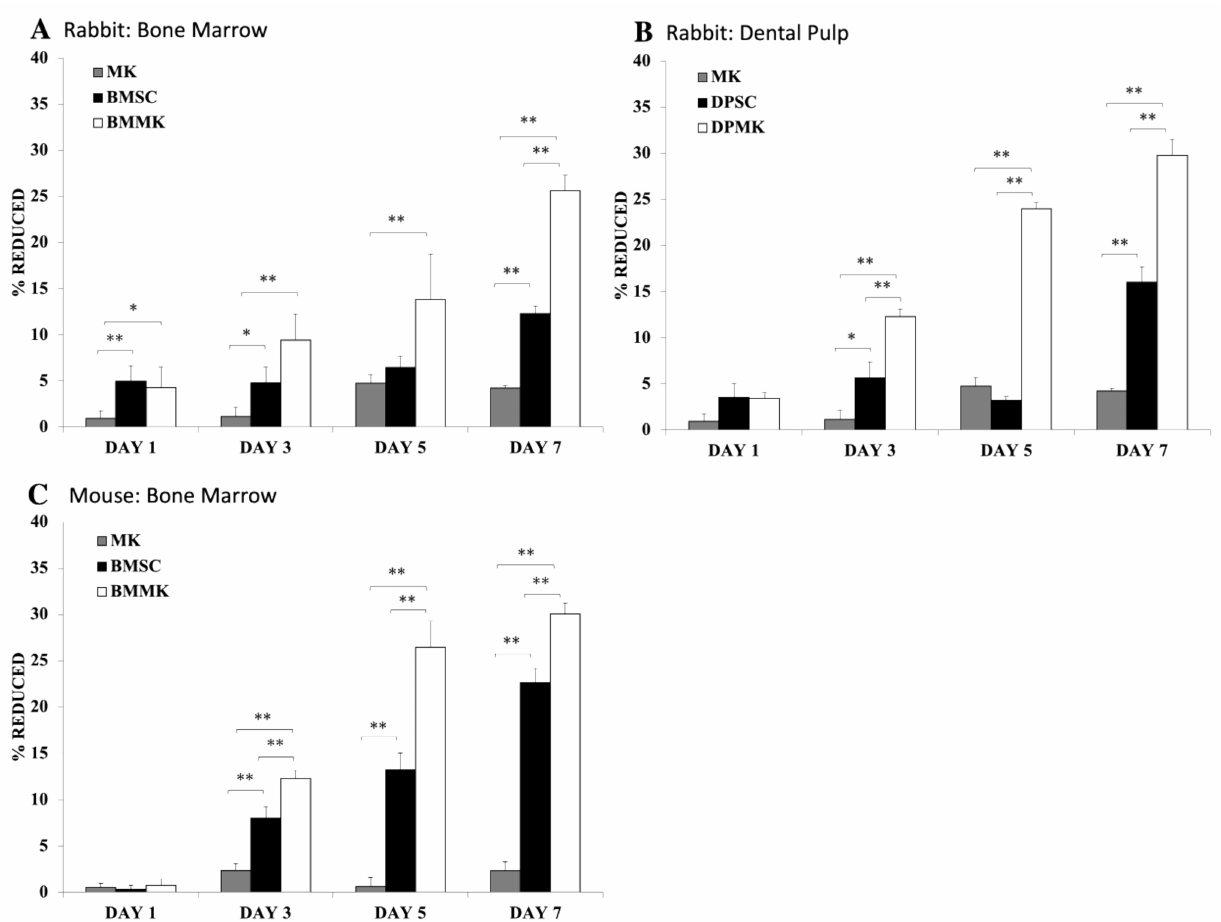
Figure 5. Shows MSC viability co-cultured with or without MKs. ( A ) shows rabbit MKs, rabbit BMSCs (BMSCs), and co-culture of rabbit MKs with rabbit BMSCs (BMMK). ( B ) shows rabbit MKs, rabbit DPSCs (DPSCs), and co-culture of rabbit MKs with rabbit DPSCs (DPMK). ( C ) shows mouse MKs, mouse BMSCs (BMSCs), and co-culture of mouse MKs with mouse BMSCs (BMMK). MSC viability was assessed on days 1, 3, 5, and 7. Increased levels of MSC viability are observed when MSCs are co-cultured with MKs at different time-points. Error bars reflect the standard deviation of the mean. A significant difference between the groups is indicated by the error bars: * = p < 0.05 and ** = p < 0.01